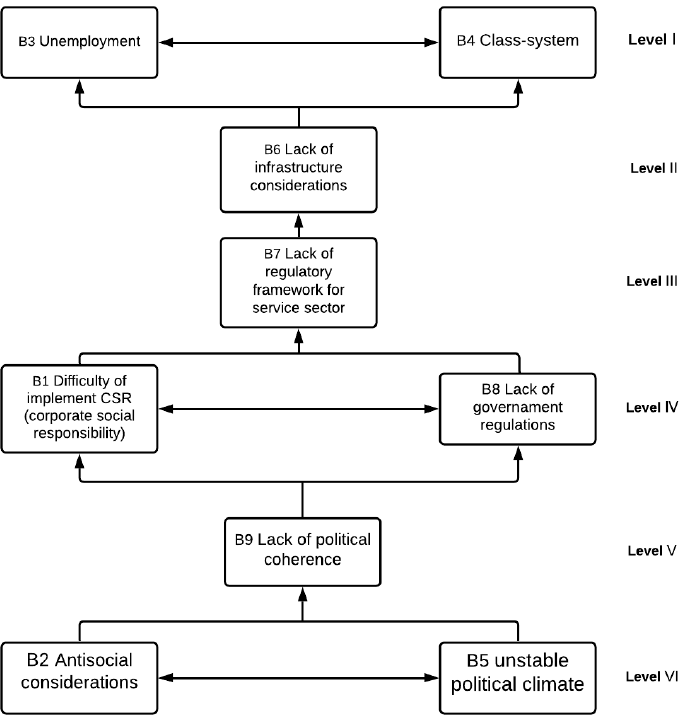
Figure 2. ISM hieratical network of the barriers of socio-political sustainability in the banking sec-